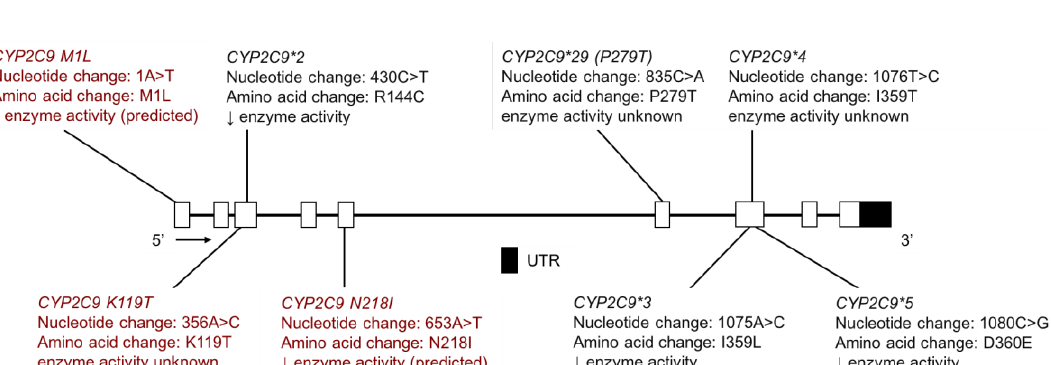
Figure 7. The human CYP2C9 gene and single nucleotide variants (SNVs) tested for in AIAN, FN, Inuit and Amerindian populations. Highlighted in red are novel variants identified by resequencing CYP2C9 in the Yup’ik, AIAN and Confederated Salish and Kootenai Tribes (CSKT) populations. Not shown is CYP2C9*6 , a frameshift mutation that results in a shortened protein. Open boxes represent exons, lines represent introns and shaded boxes represent UTR. Table 7. Comparison of novel CYP2C9 allele frequencies identified by full gene resequencing in AN and AI populations, not found in other world populations.